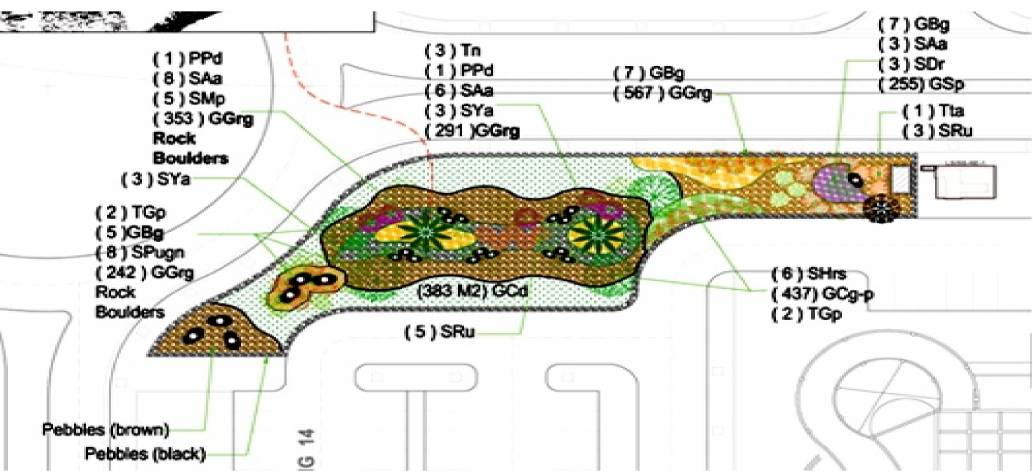
Figure 6. Applying to xeriscape for Parking 14 landscape area. Xeriscaping softscape design (Details of water consumption is shown in Table